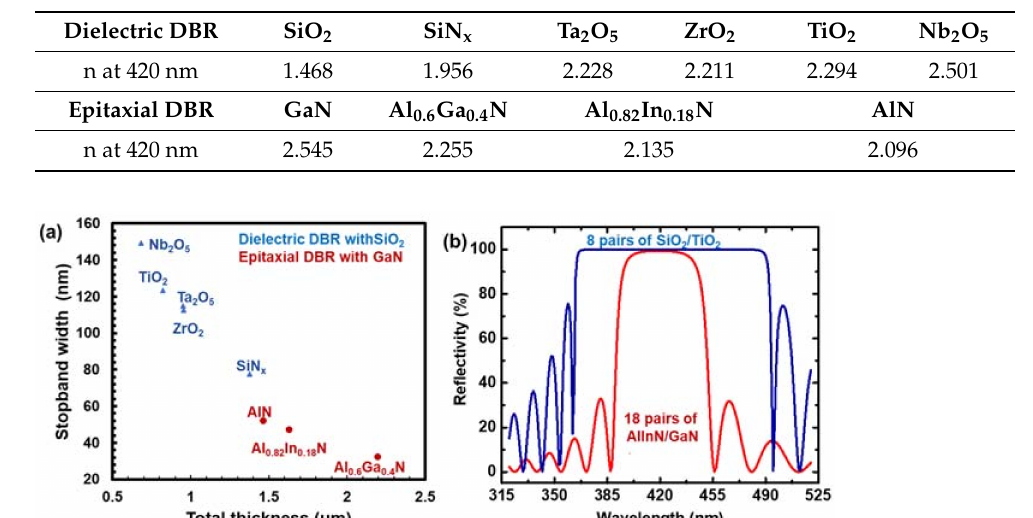
Table 3. The refractive constants of common materials used in nitride VCSELs. Parameters collected from references [59–62].